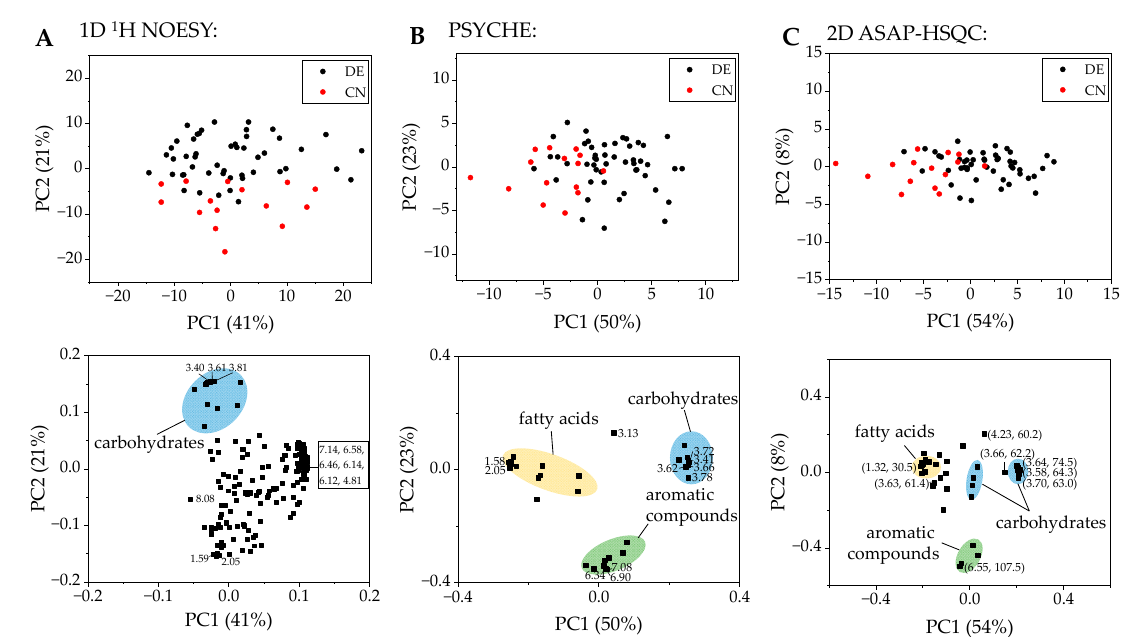
Figure 2. ( A ): PCA score plot of the differentiation of Chinese (CN) and German (DE) walnut samples using the 1D 1 H NOESY spectra with the corresponding loading plot below. Explained variance: PC1 = 41%, PC2 = 21%. ( B ): PCA score plot using the PSYCHE spectra. The corresponding loading plot is shown below. Explained variance: PC1 = 50%, PC2 = 23%. ( C ): PCA score plot obtained by the ASAP-HSQC spectra with the corresponding loading plot below. Explained variance: PC1 = 54%, PC2 = 8%.